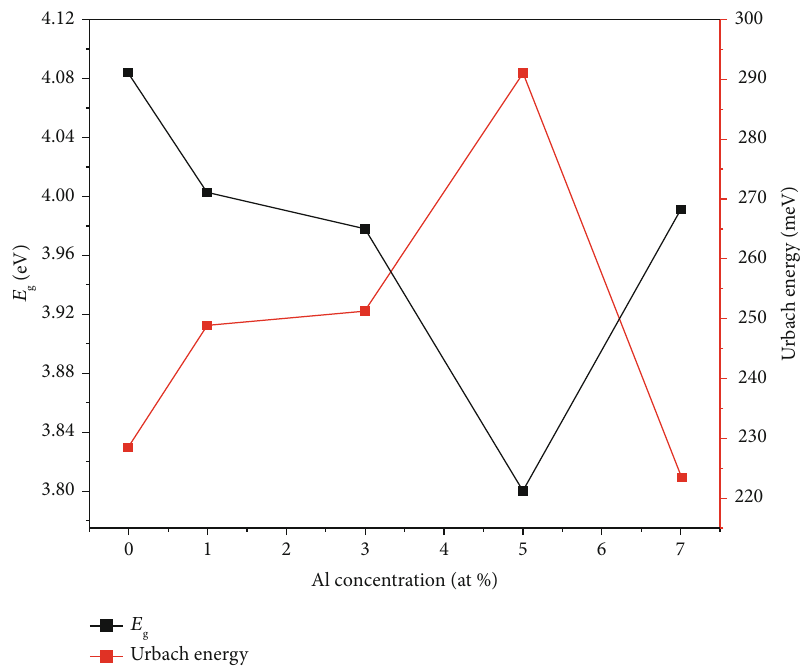
Figure 7: Energy band gap and Urbach energy of Al-Ni-codoped SnO